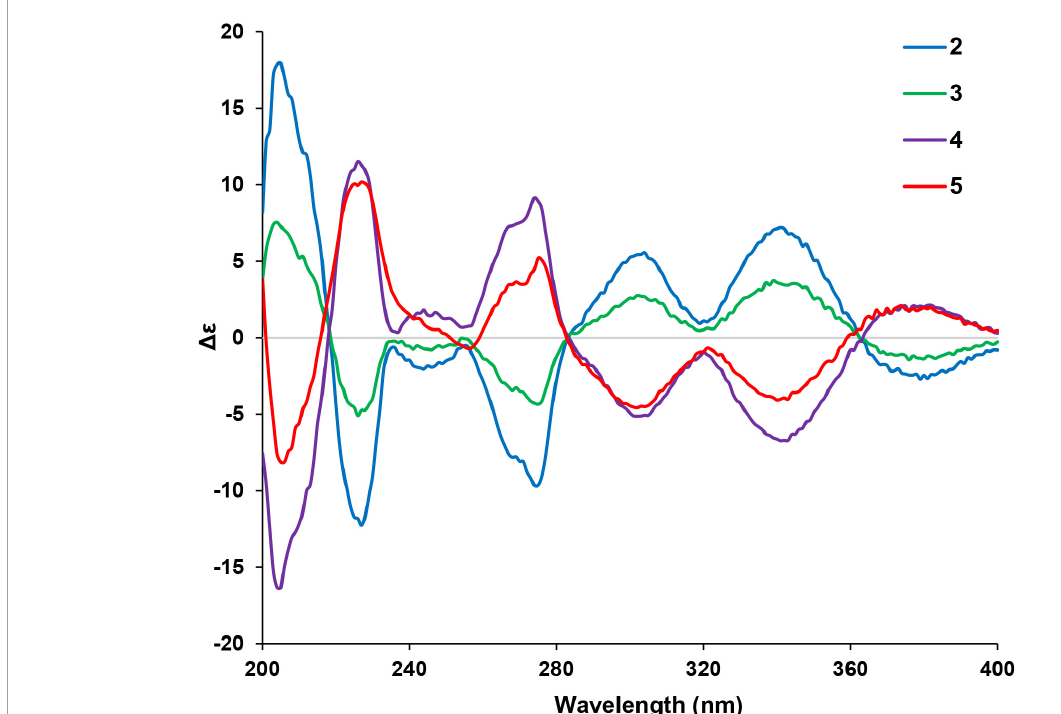
FIGURE4 Experimental CD spectra of compounds 2 – 5 .